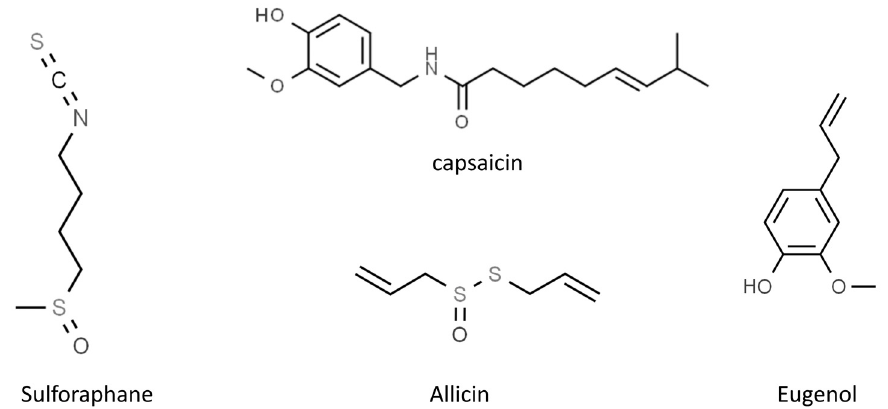
Figure 4. Chemical structure of the other selected phytochemicals (from ChemSpider, http://www.chemspider.com/ accessed on 24 February 2023).